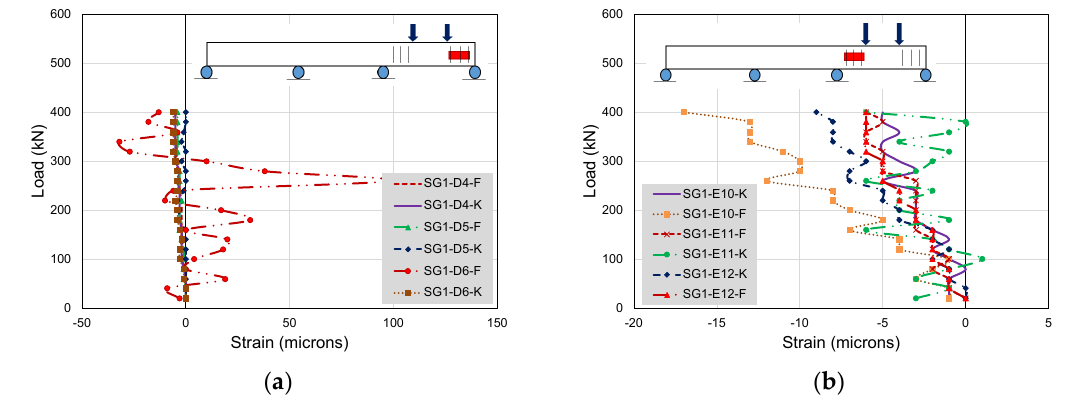
Figure 24. Load versus strain responses in load setup SP-1-L01 ( a ) D4–D6 and ( b ) E10–E12.